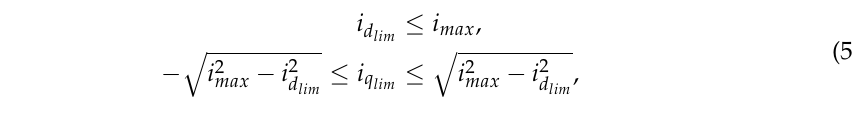
according to the current limiting lim